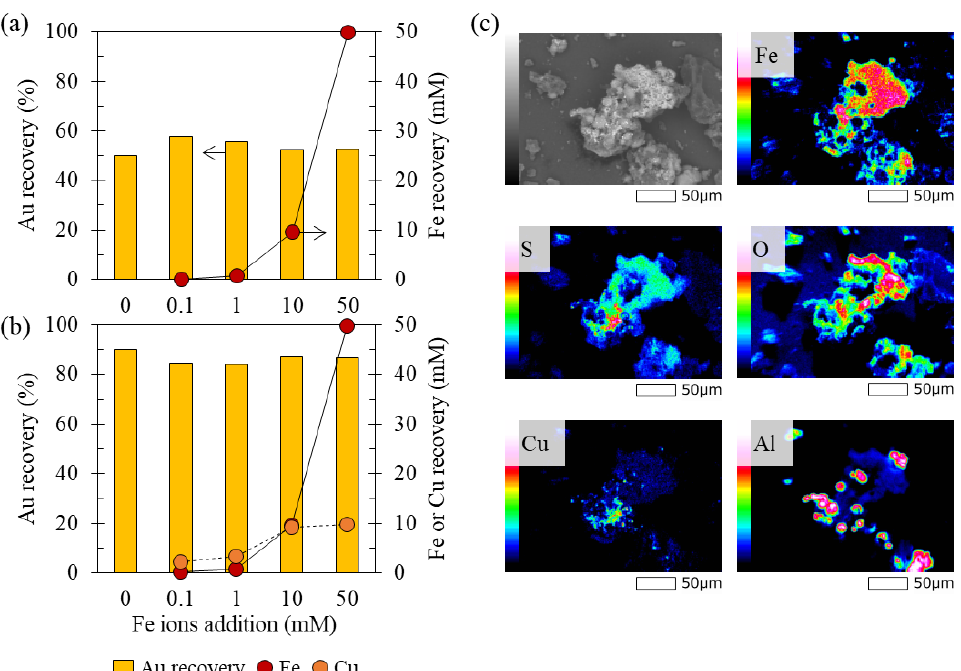
Figure 4. Recovery of gold ions from an ammonium thiosulfate solution with varying addition of Fe ion concentrations from 0 to 50 mM ( a ) without and ( b ) with 10 mM of Cu ions in the solution, and ( c ) SEM photomicrographs with corresponding elemental maps of the precipitates in the solution.